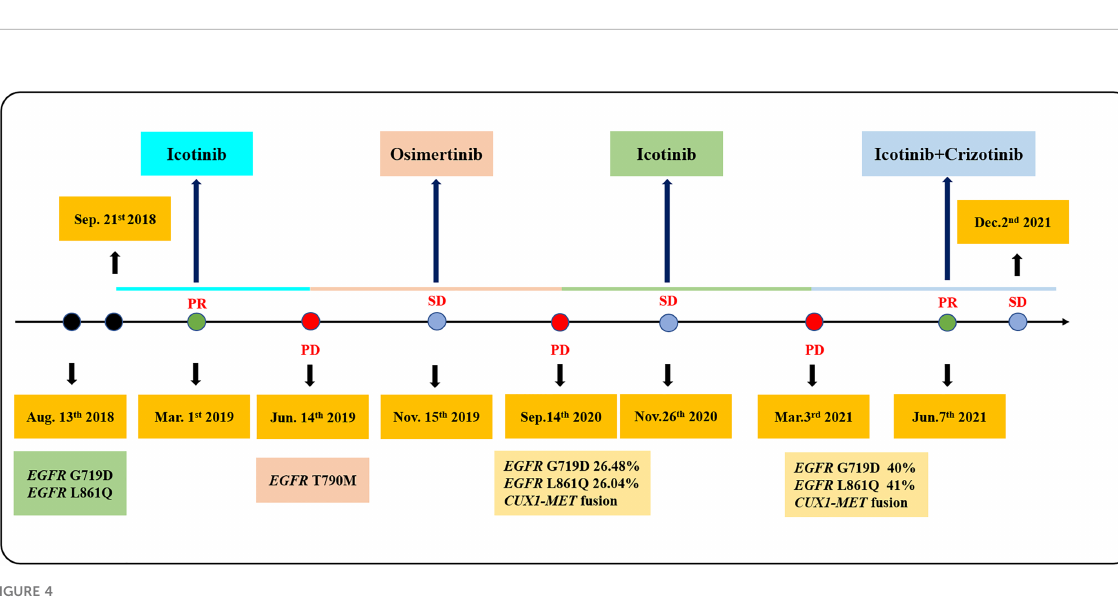
FIGURE 4 A summary of the patient ’ s